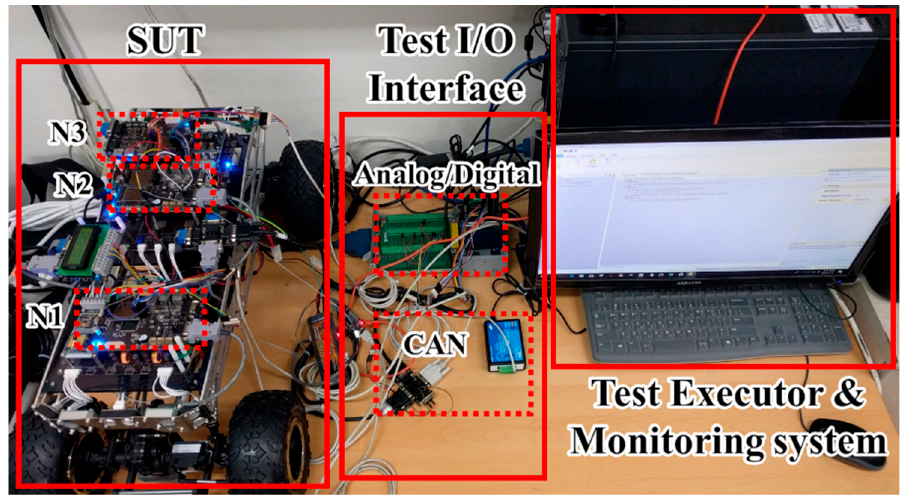
Figure 11. HiL test environment.